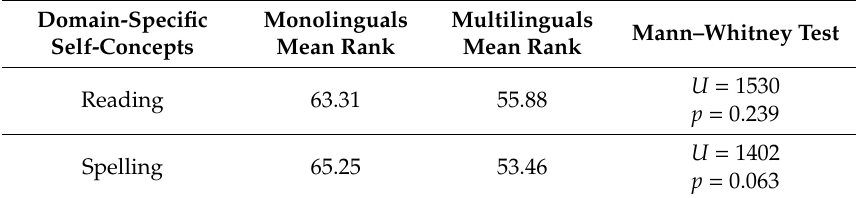
Table 2. Mean ranks for mono- and multilingual third-graders for domain-specific